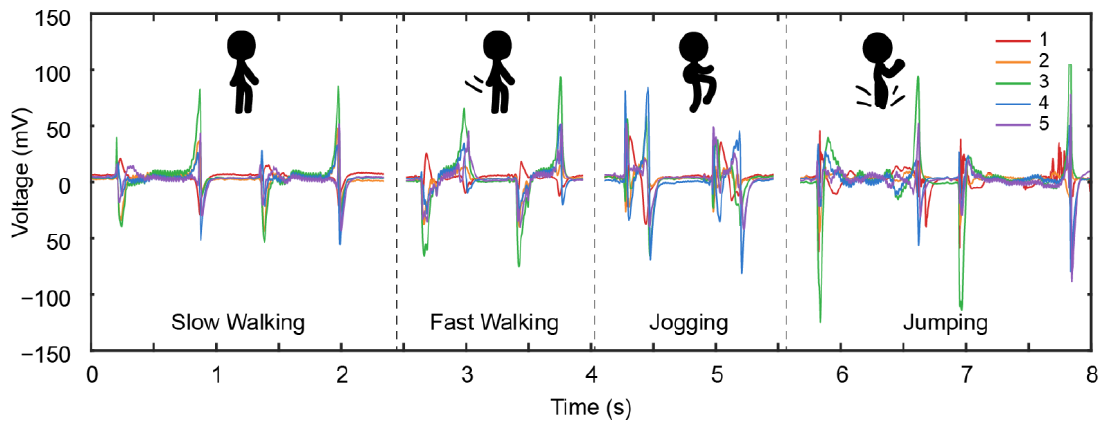
Figure 5. Activity monitoring for slow walking, fast walking, jogging, and jumping.